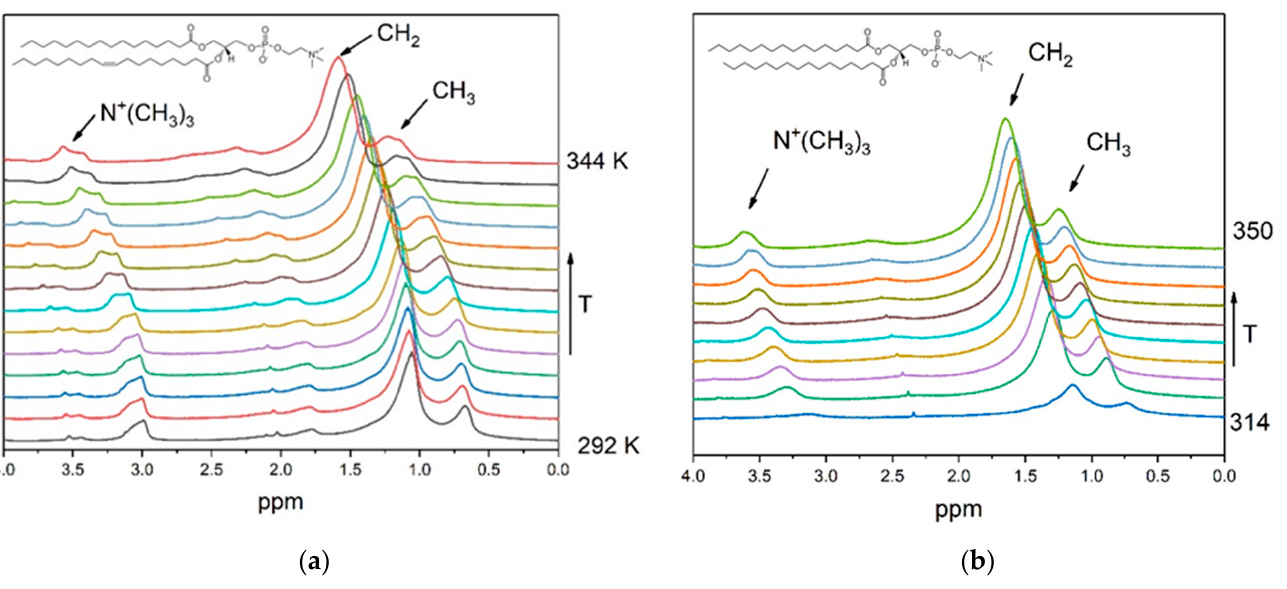
Figure 2. Fragments of 1 H NMR spectra of ( a ) POPC and ( b ) DPPC liposomes at different tempera- tures.